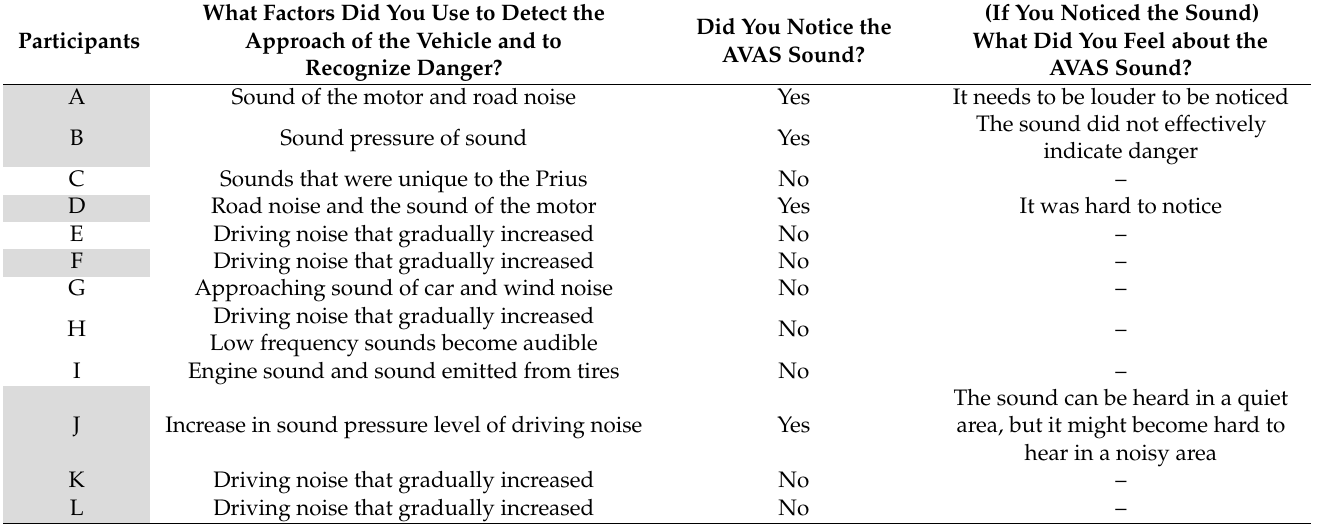
Table 3. Interview results after the experiment before the design-of-awareness process was conducted.